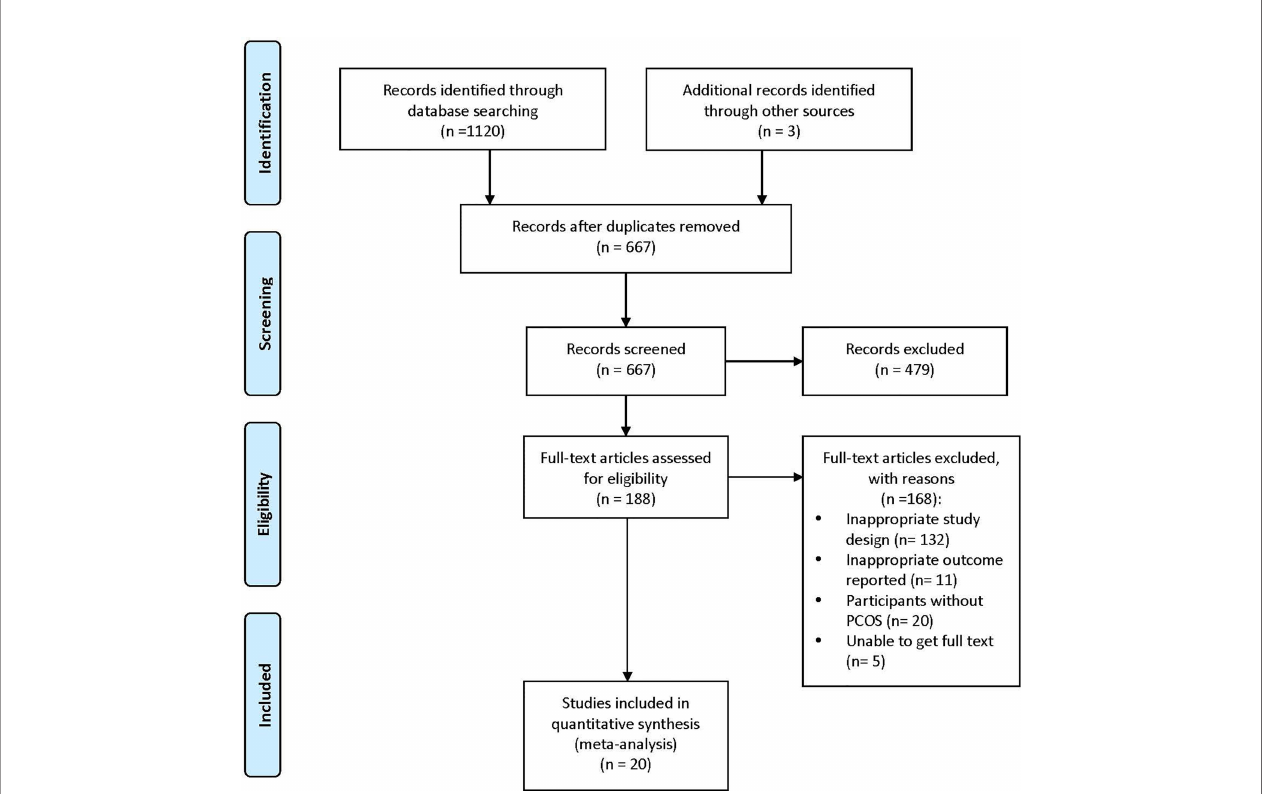
FIGURE 1 | PRISMA fl ow diagram of study selection. PRISMA, Preferred Items for Systemic Reviews and Meta-analyses; PCOS, Polycystic Ovary